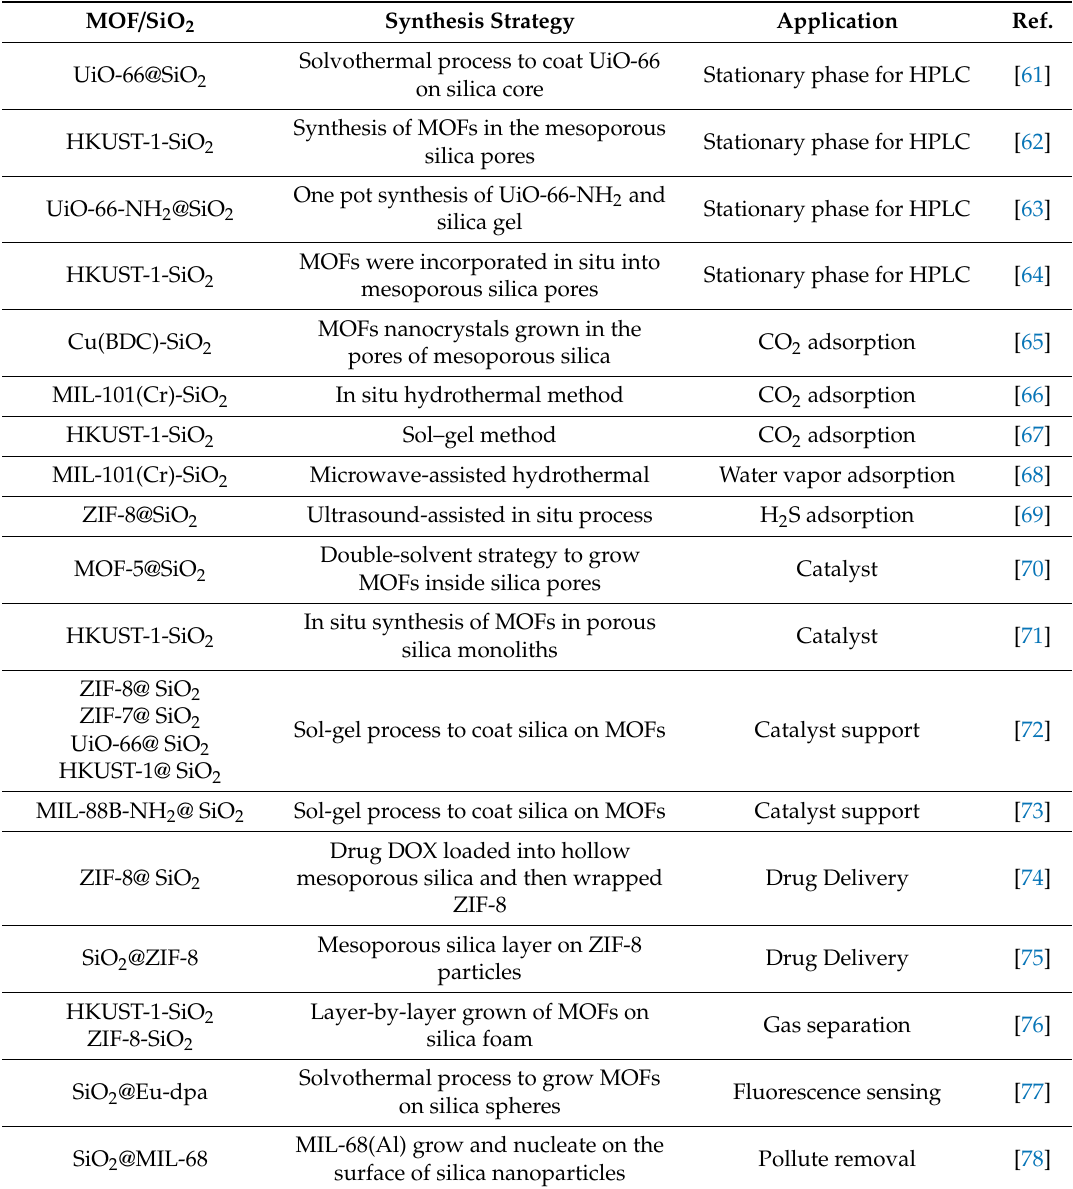
Table 1. Synthesis strategy and advanced applications of MOF / SiO 2 nanocomposites. MOF: metal organic